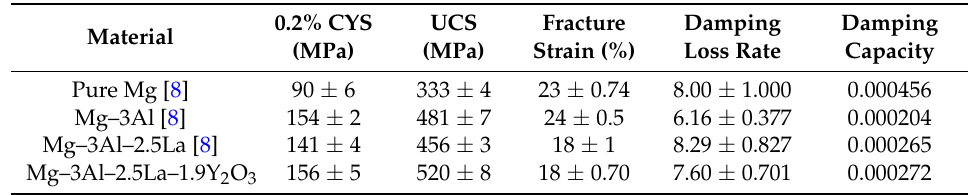
Compression properties: Table 2 and Figure 5 show the room-temperature compression properties of extruded pure Mg, Mg–3Al, Mg–3Al–2.5La and Mg–3Al–2.5La–1.9Y 2 O 3 samples under